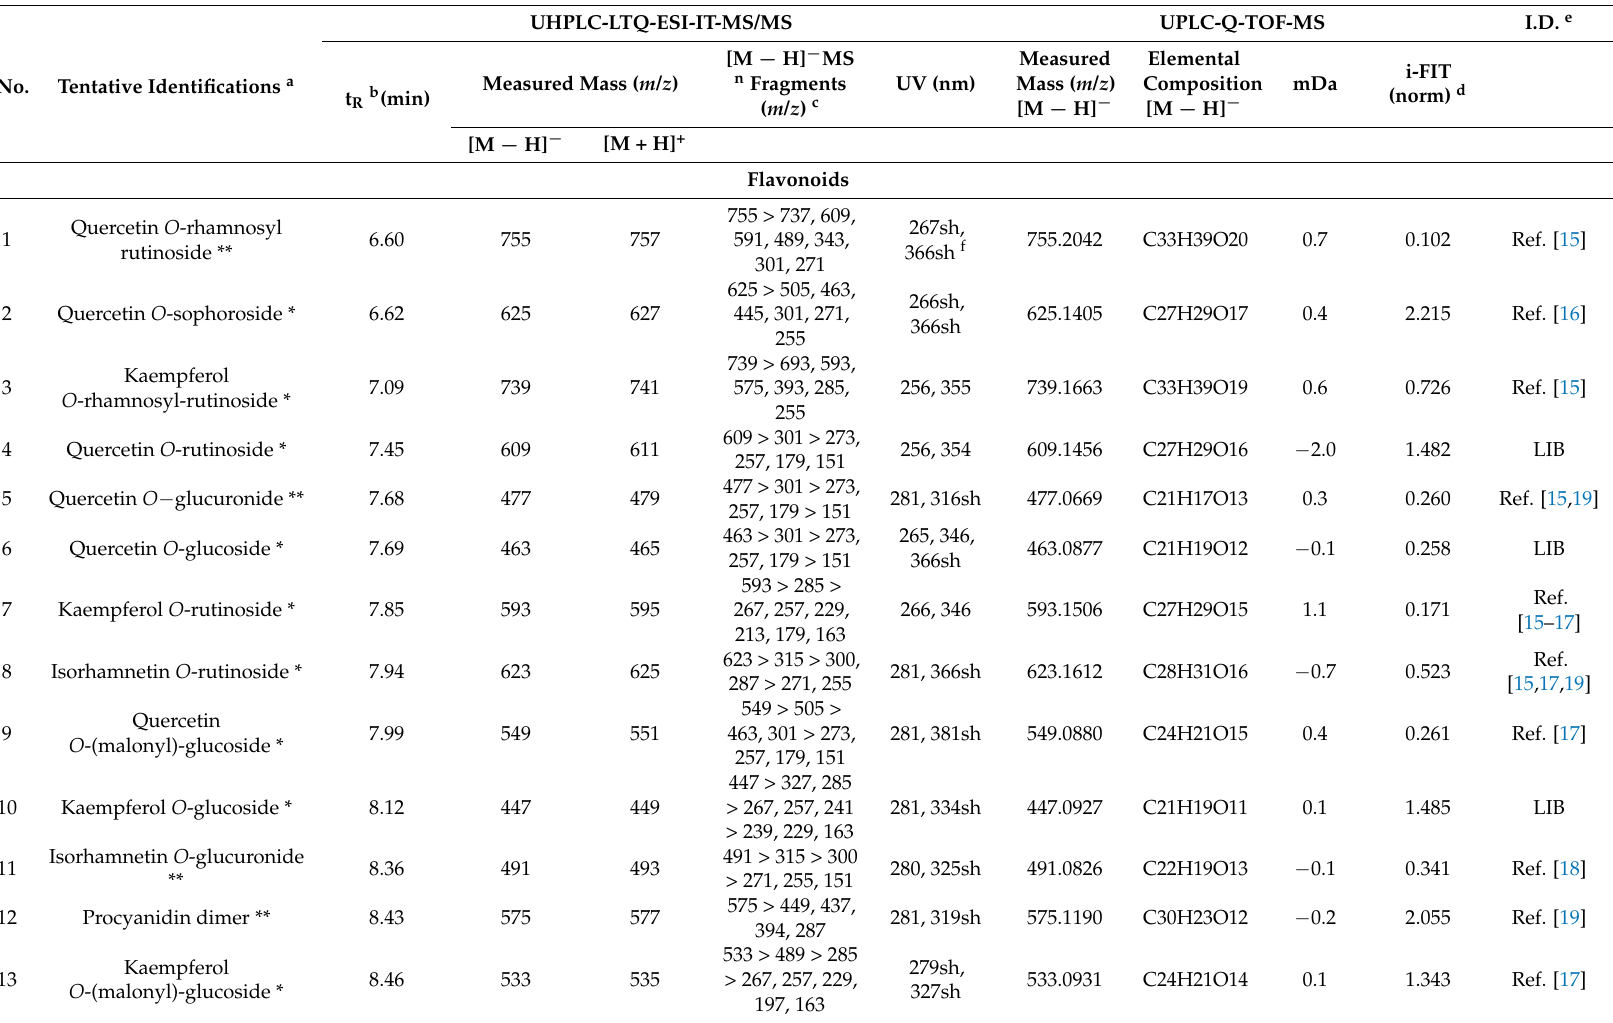
Table 1. Identification of tentative compounds to be used as variables to classify 40% SPE extracts of A. aspera and Z. serrata on the basis of LC-MS results.